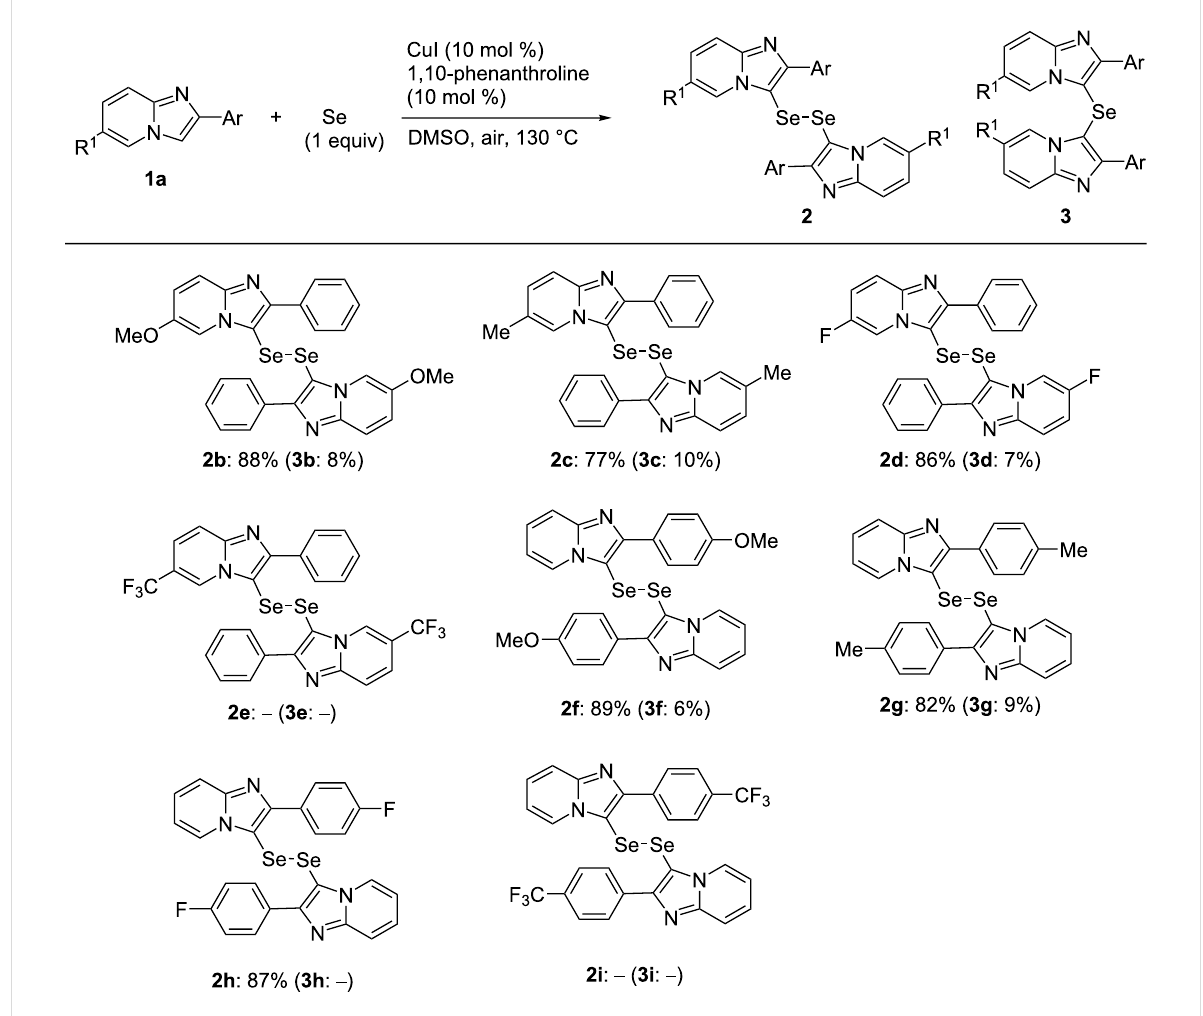
Figure 3: The synthesis of bis(2-arylimidazopyridin-3-yl) diselenides. Reaction conditions: 1 (2 mmol), Se (2 mmol), CuI (0.2 mmol), 1,10-phenanthro- line (0.2 mmol), DMSO (8 mL), 130 °C, 3 h. The isolated yield is given.